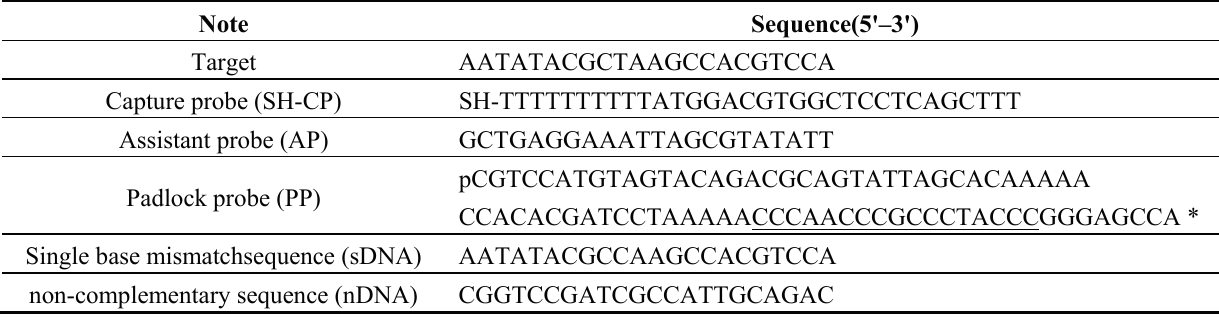
Table 1. The oligonucleotide sequences used in our